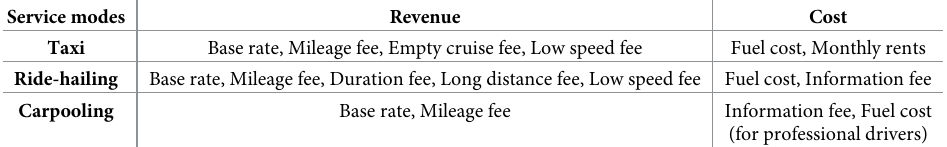
Table 1. Factors used to calculate cost and